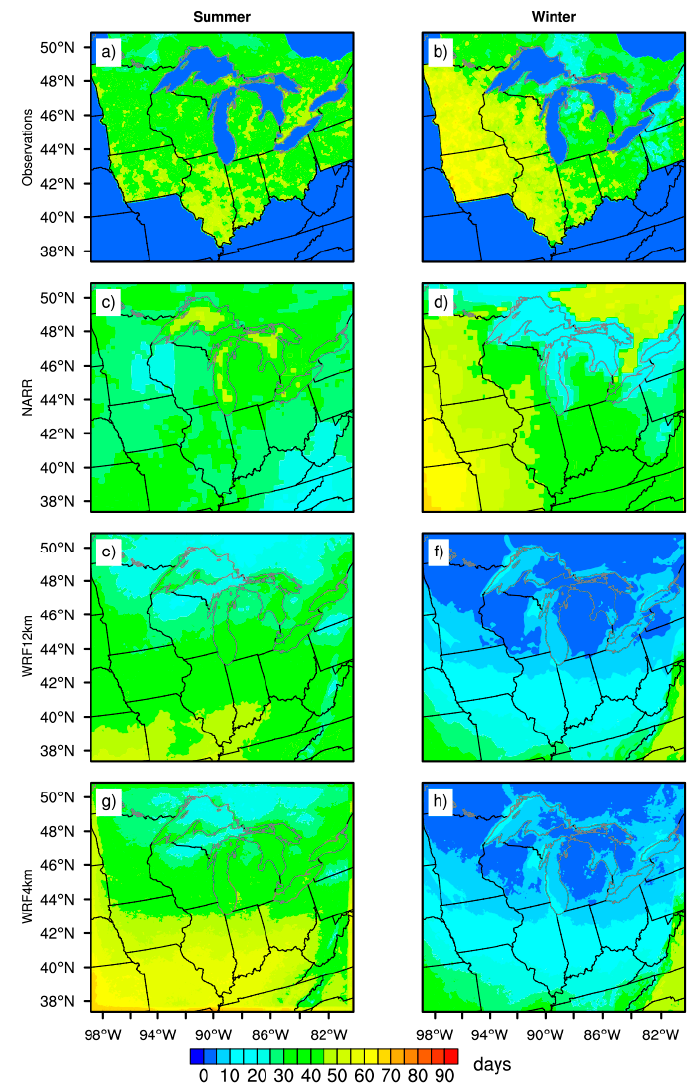
Figure 9. Same as Figure 7, but for the average number of dry days per year.